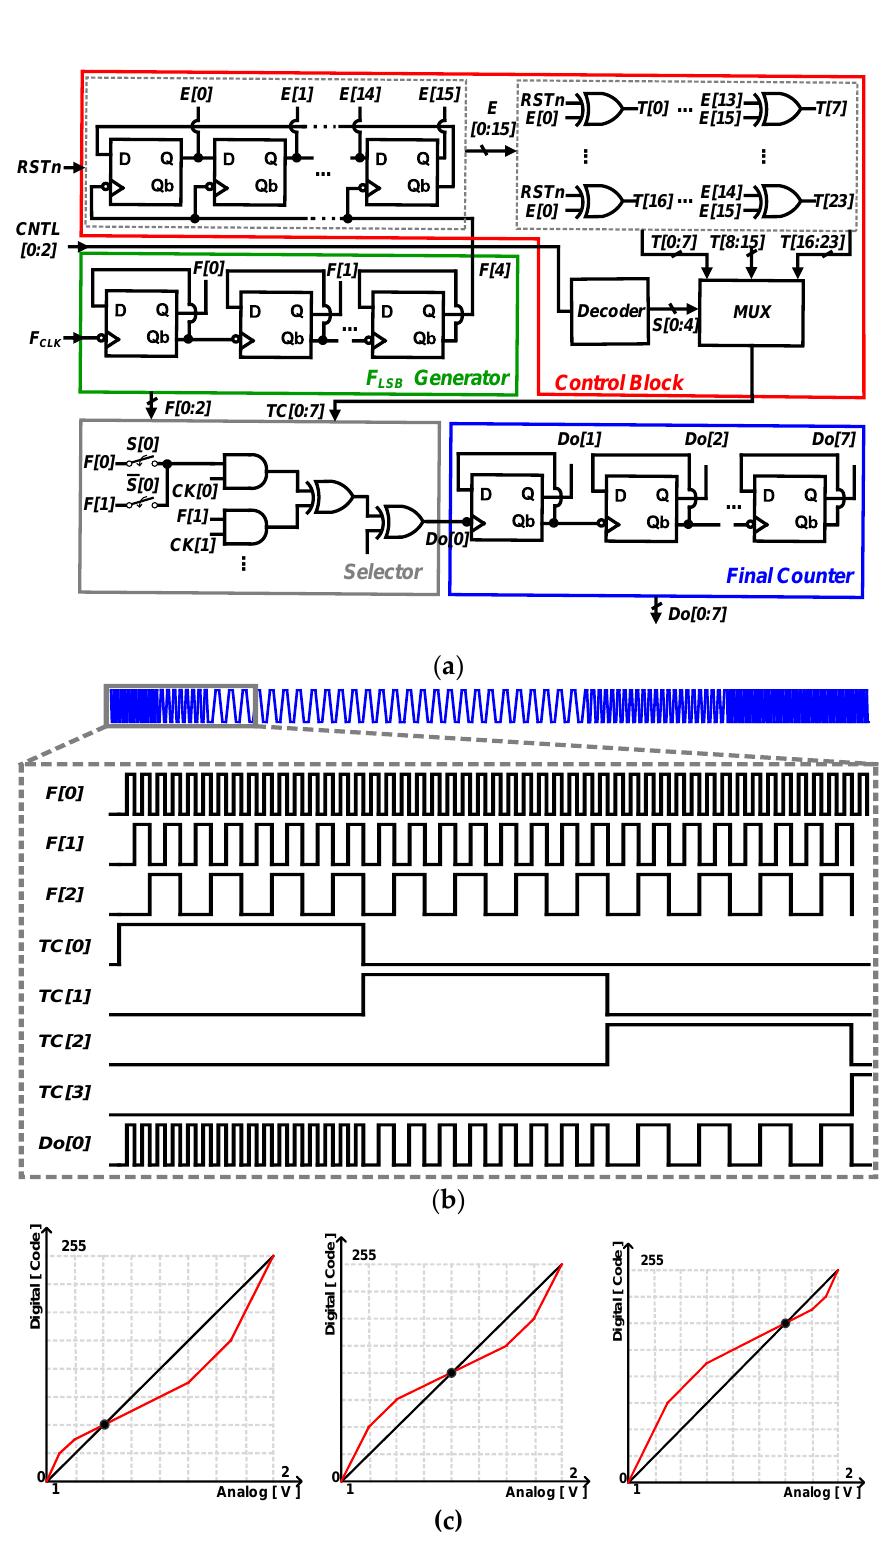
Figure 5. ( a ) Block diagram of the global LCE, ( b ) timing diagram, and ( c ) different bi-directional gamma curvatures.